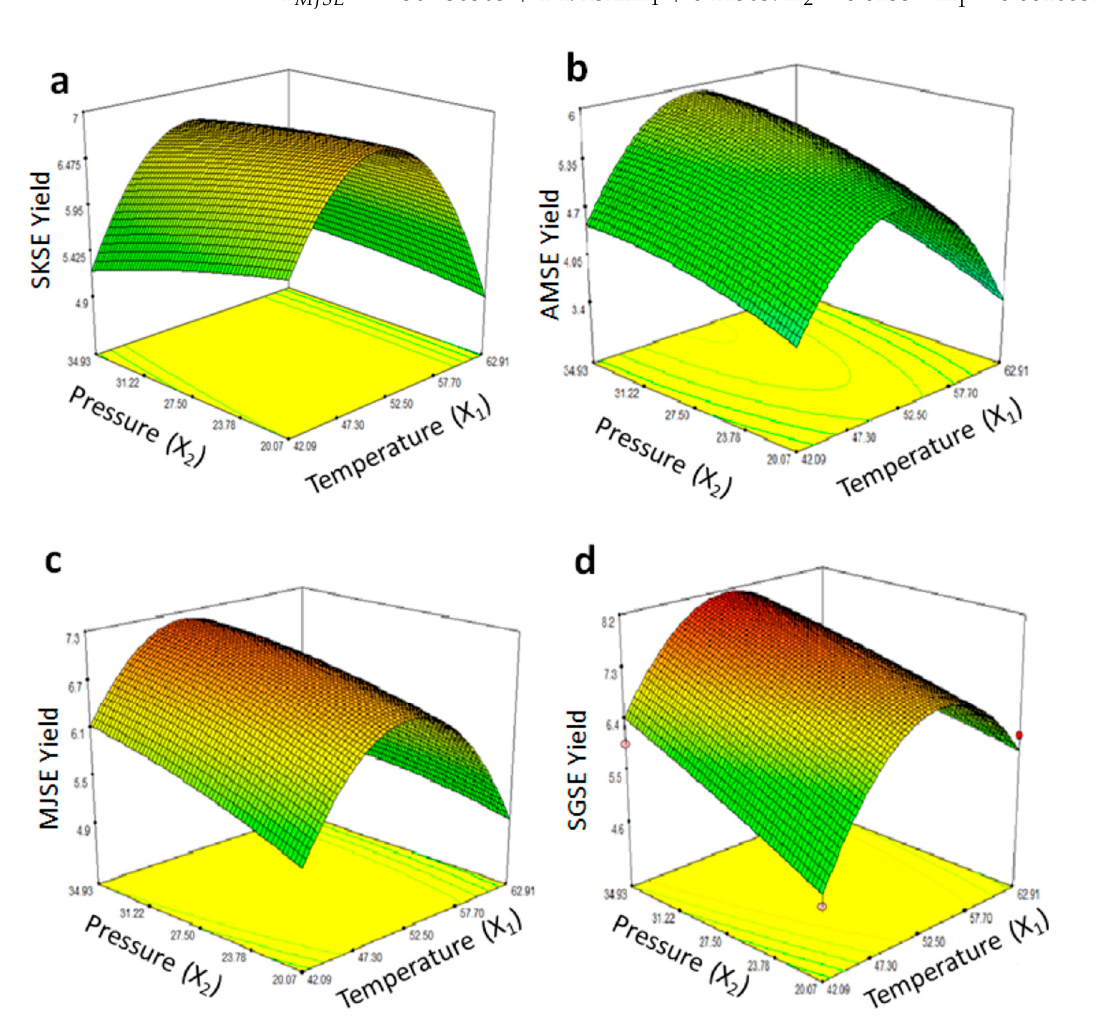
Figure 1. Response surface plots of process variables (temperature and pressure) and extract yields from Sukari (SKSE, ( a )), Ambara (AMSE, ( b )), Majdool (MJSE, ( c )) and Sagai (SGSE ( d )) seed extracts obtained using supercritical fluid (CO 2 ) extraction